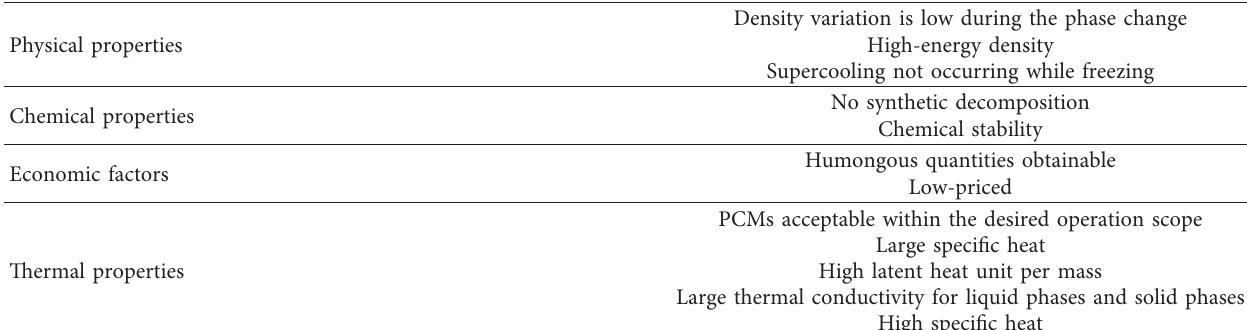
Table 3: Most preferable properties of PCM.